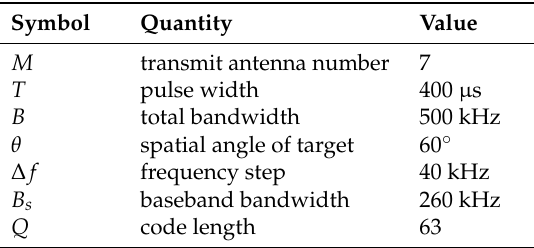
Table 1. Parameter setup for the